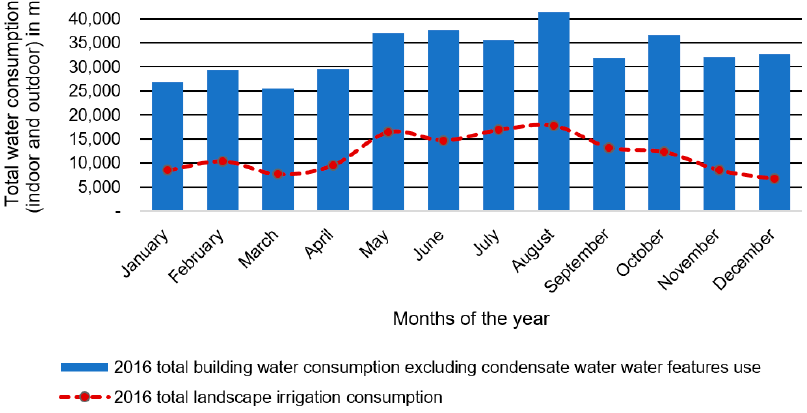
Figure 2. Medical facility case study (MFCS) total building water use against LI consumption based on 2016 Abu Dhabi Distribution Company (ADDC) water bills [6,10].